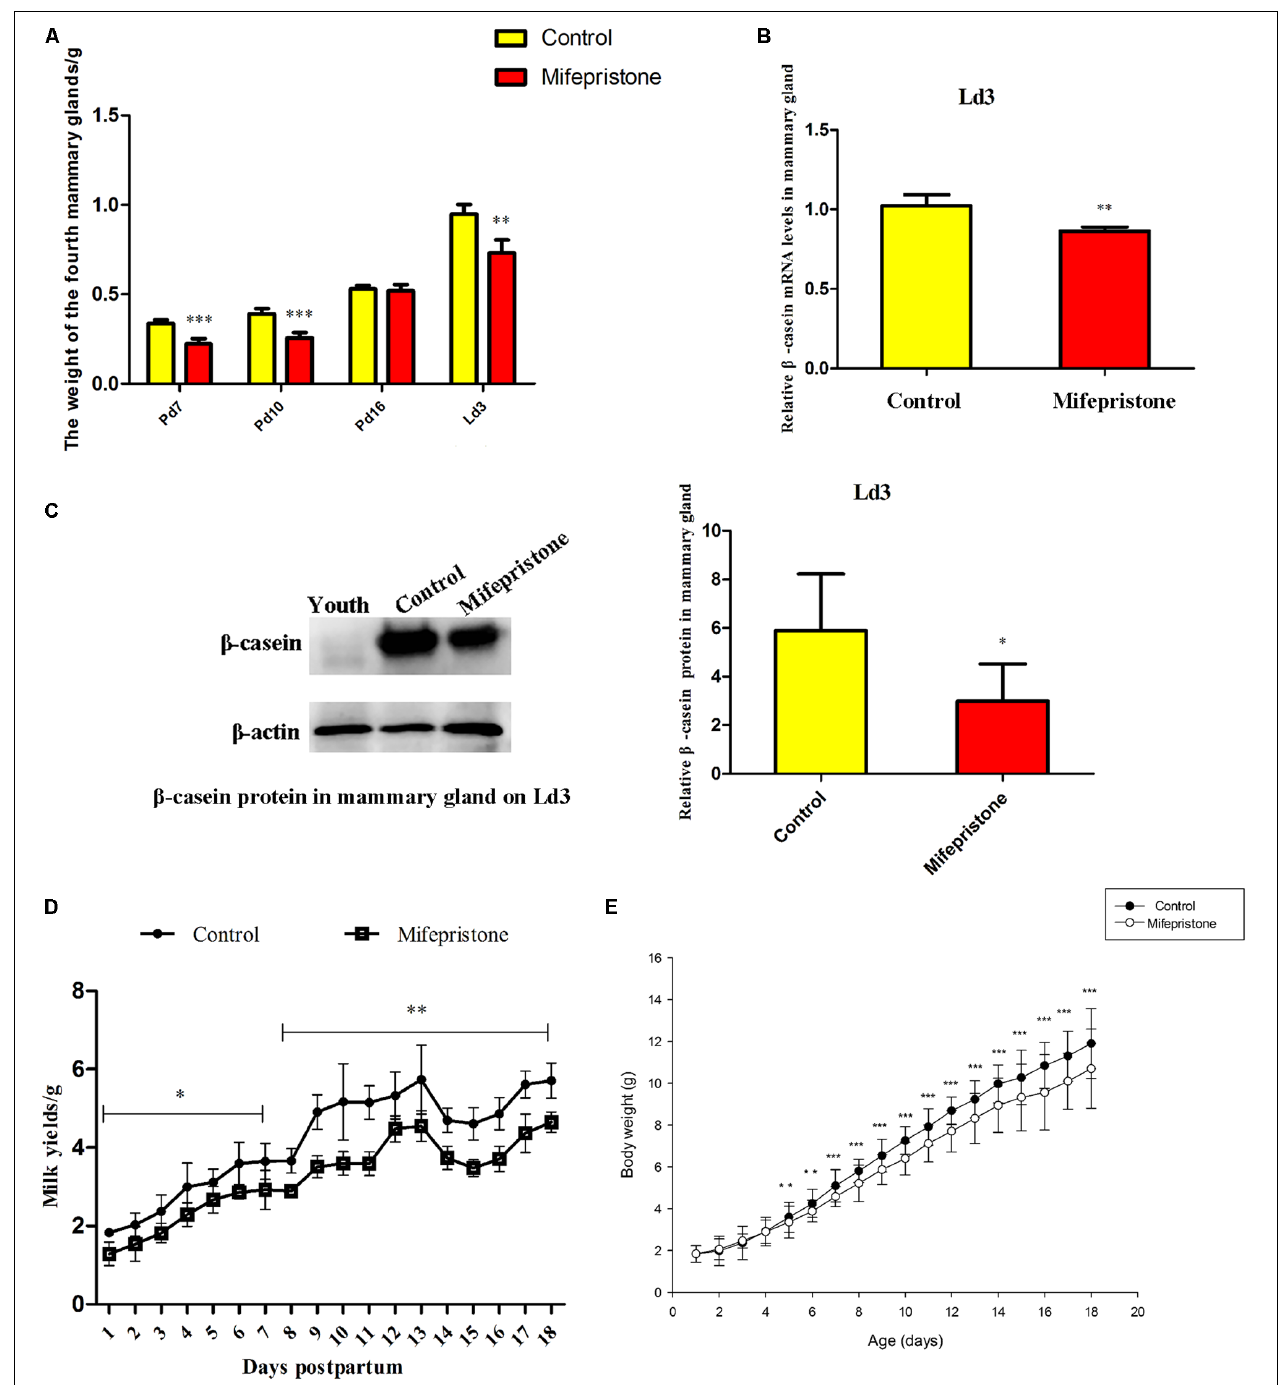
FIGURE 3 | Effects of mifepristone administration on pregnancy day 4 (Pd4) on mammary glands weight, β -casein expression, milk yields and litter growth rates during pregnancy and early lactation. (A) The weight of the fourth mammary glands on Pd7, Pd10, Pd16, and lactation day 3 (Ld3) after mifepristone administration. (B) qRT-PCR analysis of β -casein mRNA on Ld3. This experiment was repeated at least three times. (C) Western blot analysis for β -casein expression on Ld3. The evaluation of β -casein relative to β -actin in two groups were calculated with integrated optical identity (IOD). (D) Milk yields of dams from Ld1 to Ld18 after parturition, determined via weigh-suckle-weigh method. (E) Body weight gain in pups from Ld1 to Ld18. Data are represented as means ± SD, ∗ indicates the difference between mifepristone group and control group, ∗∗ P < 0.01, ∗∗∗ P < 0.001.